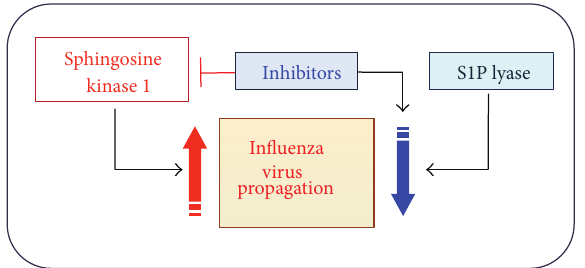
Figure 2: Modulation of influenza virus amplification by sphingo- sine kinase 1 and S1P lyase. SK1 increases influenza virus replication, whereas S1P lyase inhibits virus propagation. Manipulation of SK1 such as SK1 inhibition suppresses production of infectious influenza viruses.